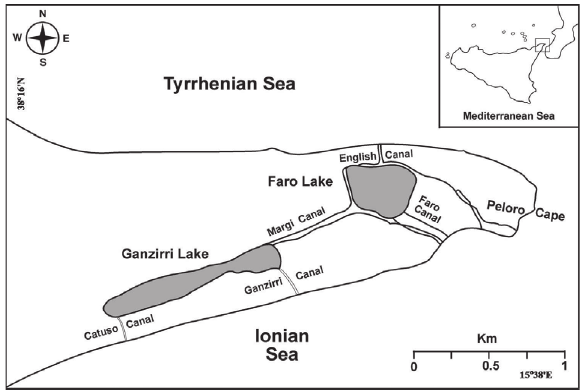
Fig . 1. – location of lake faro at the northeastern tip of